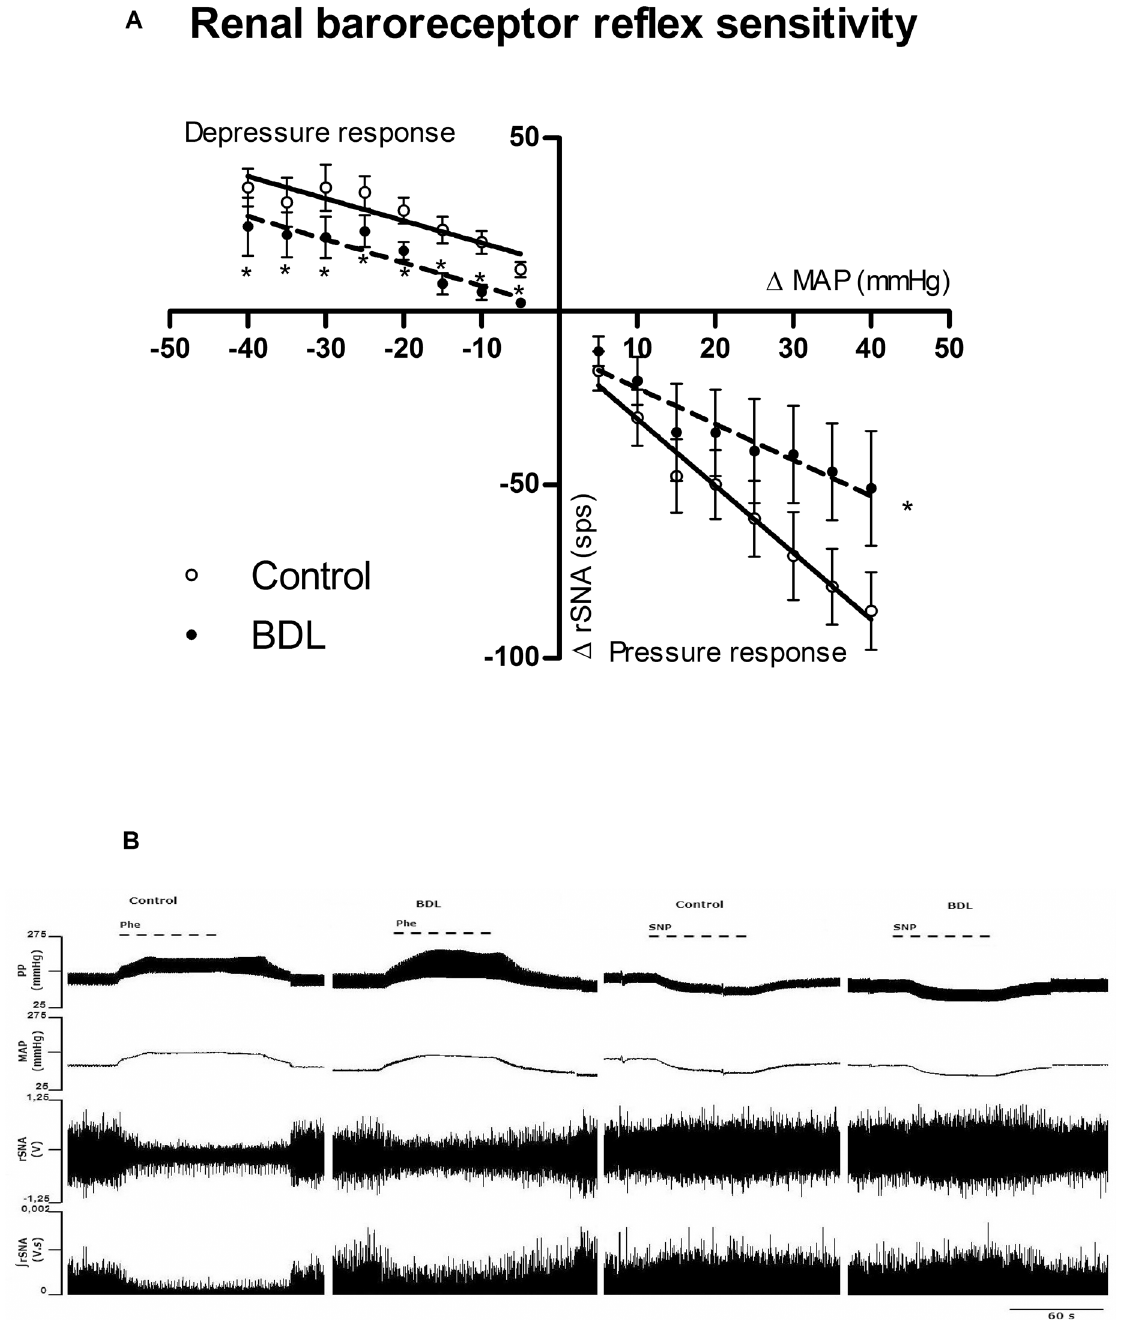
Fig 4. Baroreceptor reflex sensitivity for renal sympathetic nerve activity (rSNA). ( A ) Linear regression graph showing: depressor response — the reflexive increase in rSNA to decrease the mean arterial pressure (MAP) produced by ramp infusion of sodium nitroprusside (200 μ g/ml, 6ml/h, iv); and pressor response — rSNA decrease reflex response to increase MAP produced by ramp infusion of phenylephrine (100 μ g/ml, 6ml/h, iv) for 60 seconds in the control and bile duction ligation (BDL) groups. n, number of rats * P < 0.05 compared to control group (Sutdent ’ t test). ( B ) Representative recording cardiovascular and autonomic responses induced by ramp infusion of phenylephrine (Phe) and sodium nitroprusside (SNP) in the control and BDL groups. Pulse pressure (PP), mean arterial pressure (MAP), rSNA expressed in volts (V) and integrated ( ʃ ) rSNA expressed in volts-seconds (V.s).